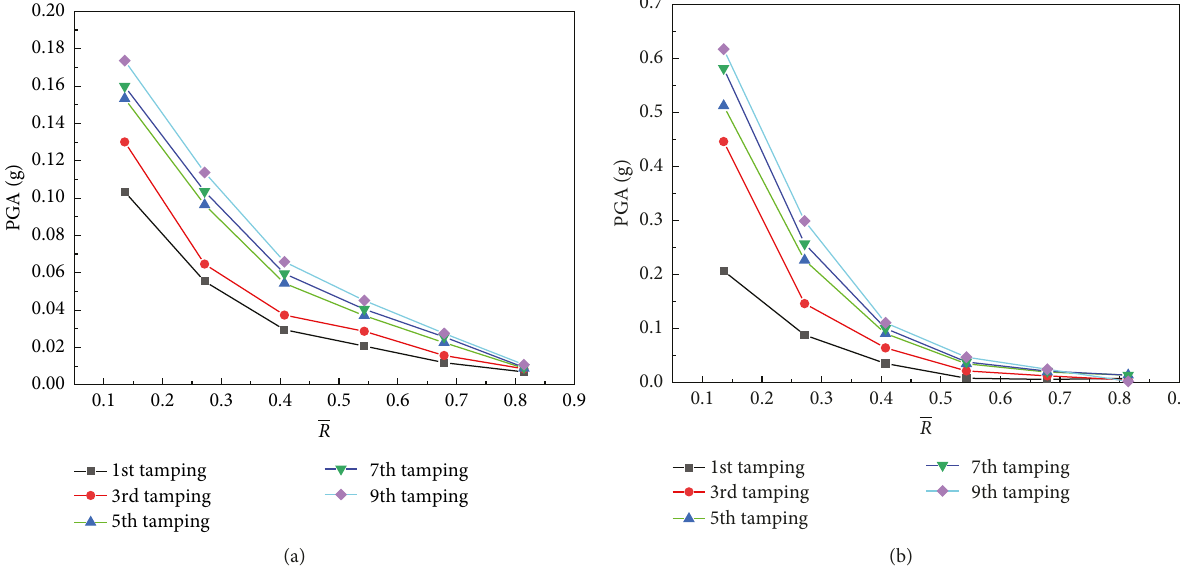
Figure 9: Attenuation of PGA with distance under different times of tamping. (a) In radial direction. (b) In vertical direction. Table 3: Attenuation parameters of PGA under odd time tamping.